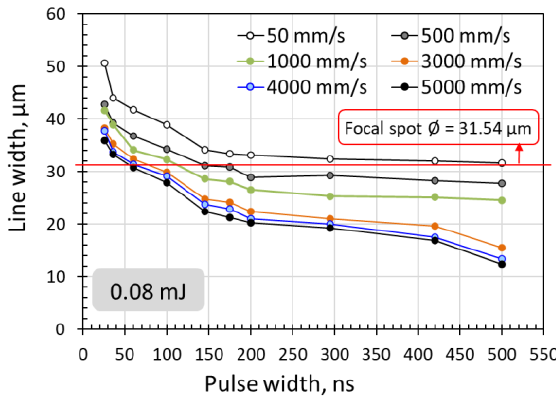
Figure 9. Reduction of scanning line width with increasing pulse width for 0.08 mJ pulse energy (10.24 J/cm 2 ) at various scanning speeds.